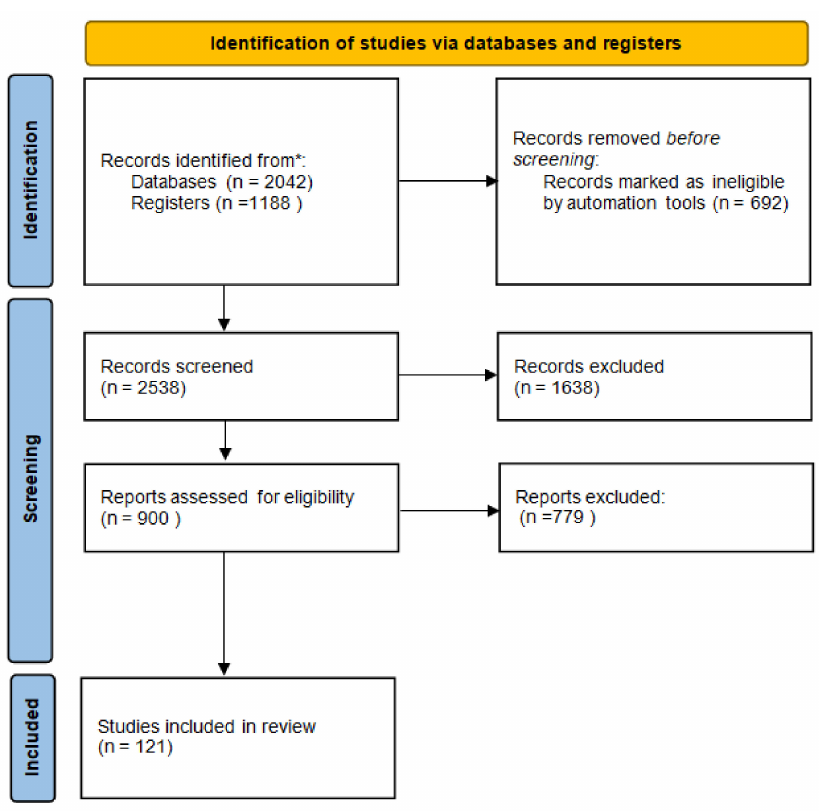
Figure 1. Flow diagram of systematic review. * The databases were last accessed on 31 January